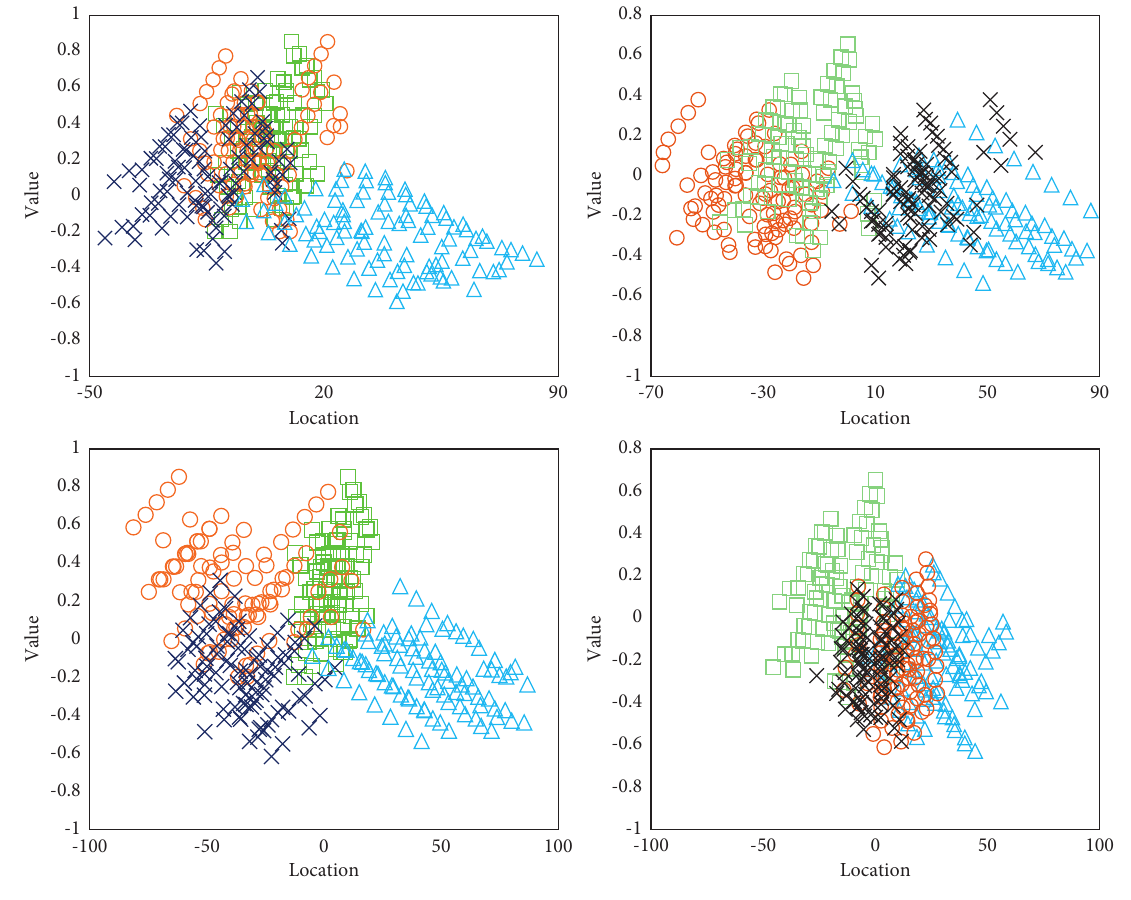
Figure 4: Predicted